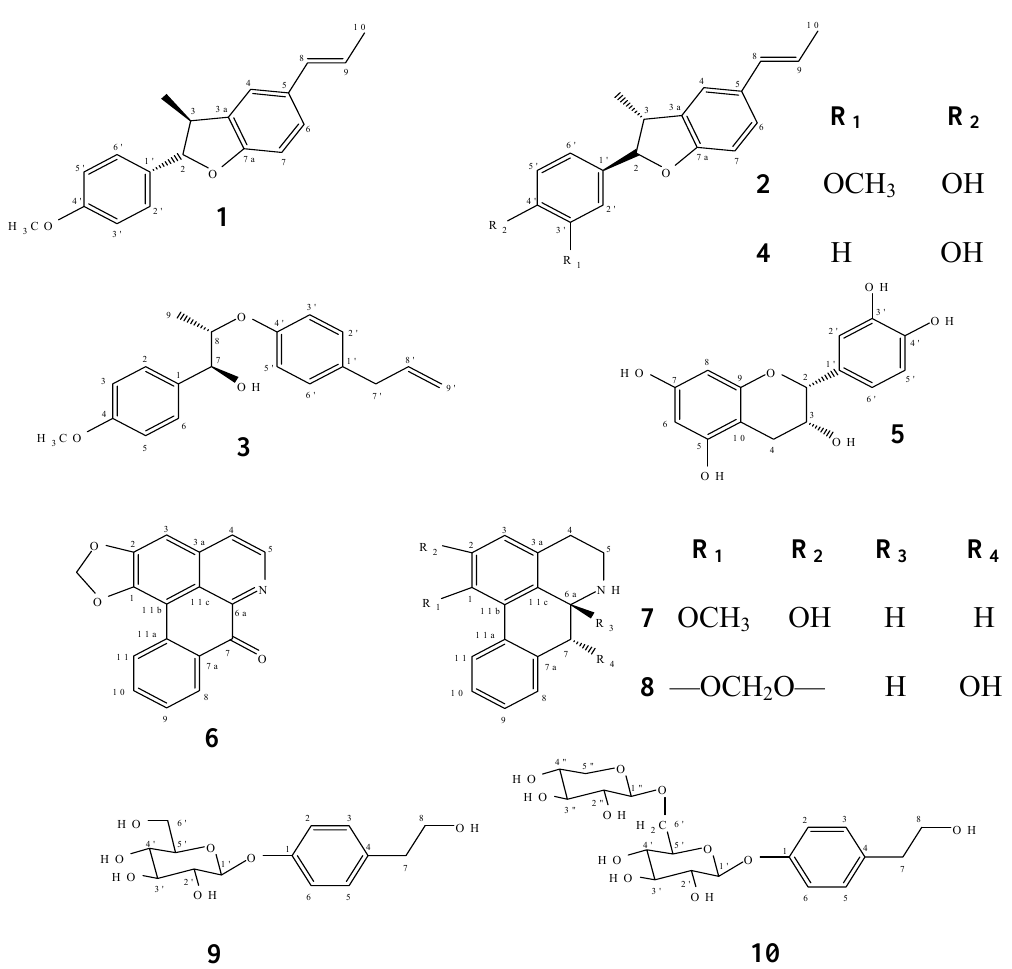
Figure1. Compounds isolated from Miliusa